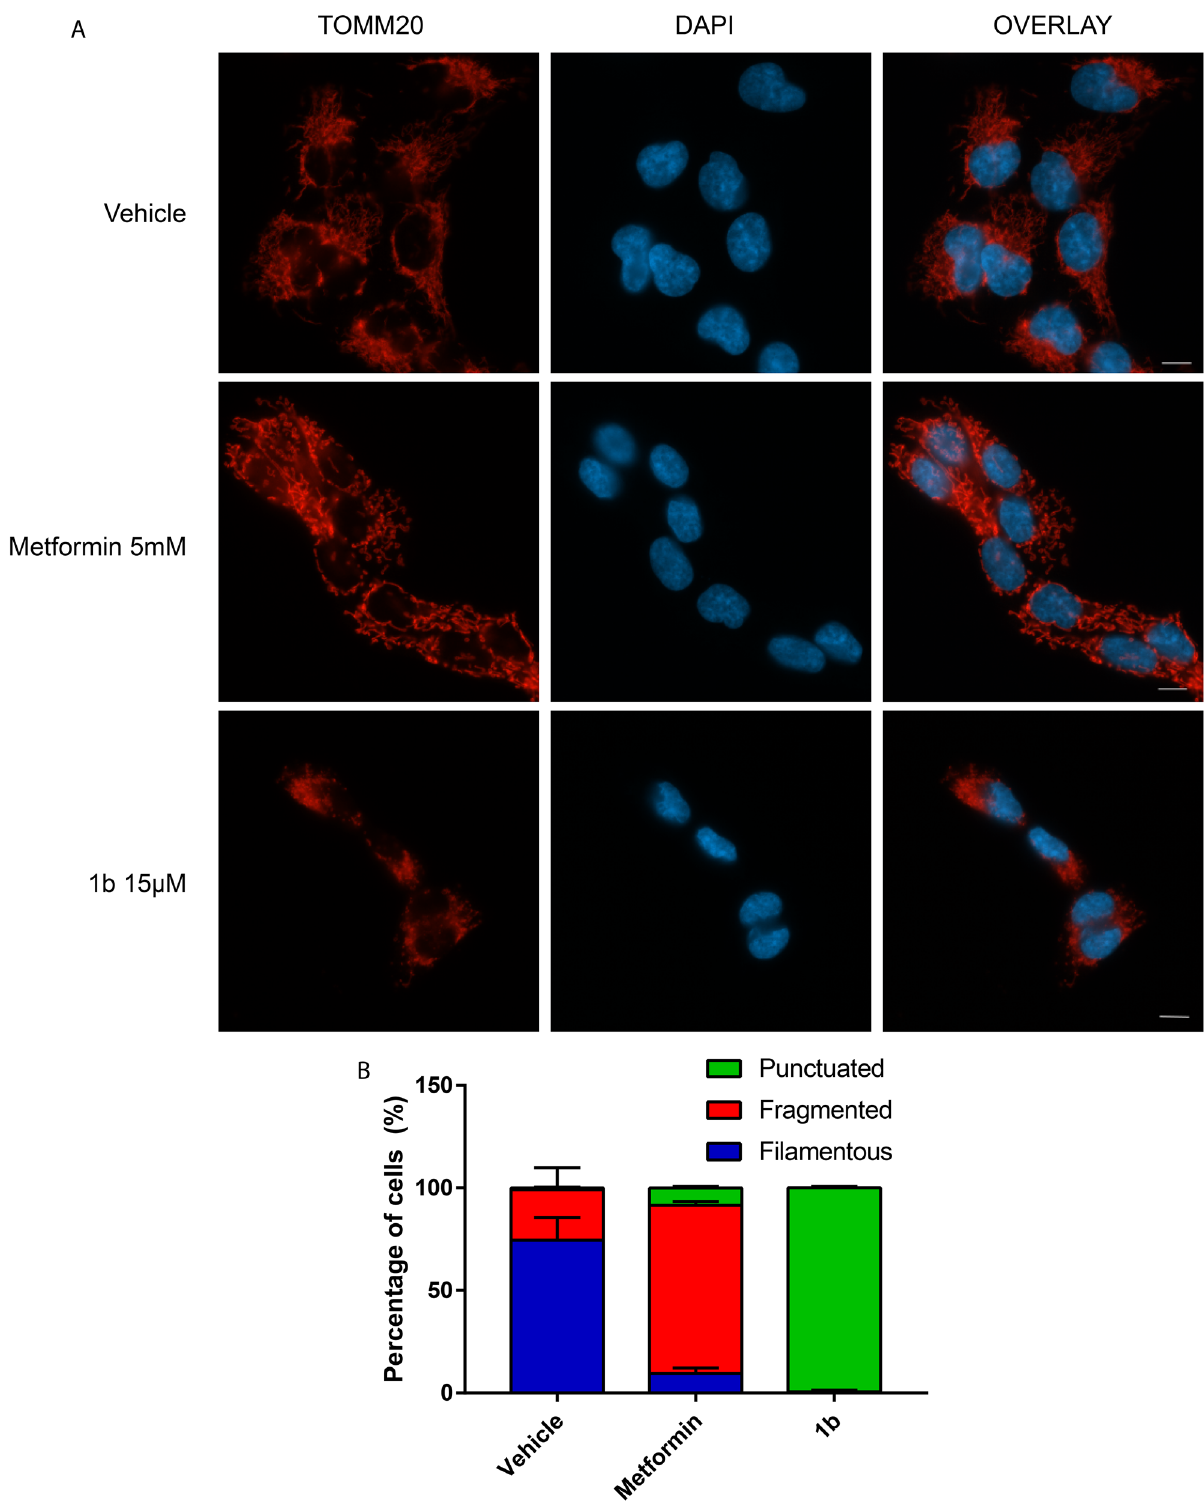
Figure 4. Effects of biguanides on mitochondrial morphology. ( A ) Mitochondrial morphology in KP4 cells 24 h following the indicated treatments as visualised by anti-TOMM20 immunofluorescence. Scale bar = 10 µM. ( B ) Quantification of the percentage of cells exhibiting filamentous, fragmented or punctuated mitochondria following indicated treatments. The data represents the mean of 2 biological replicates and for each replicate three counts of 50 cells were done. n = 300 cells per treatment. Data was analyzed with one way ANOVA followed by Tukey HSD